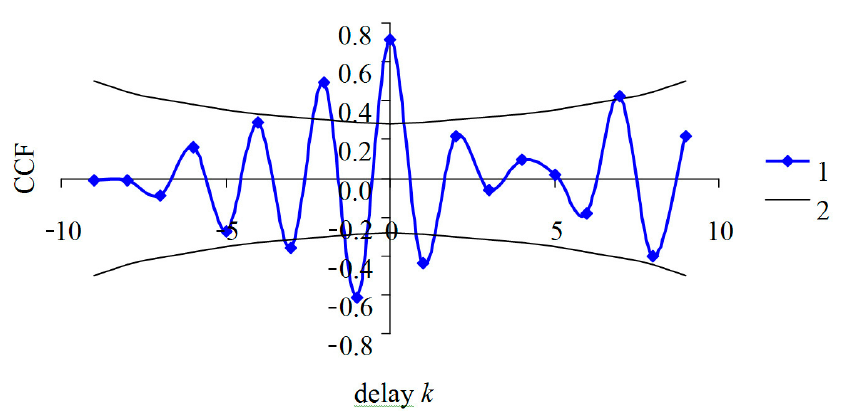
Figure 7. Cross-correlation function (CCF) of the field and model data series for sample plot No. 1. 1–CCF; 2–Standard Error of CCF. Table 5. Parameters of model (2) based on the data averaged over the sample